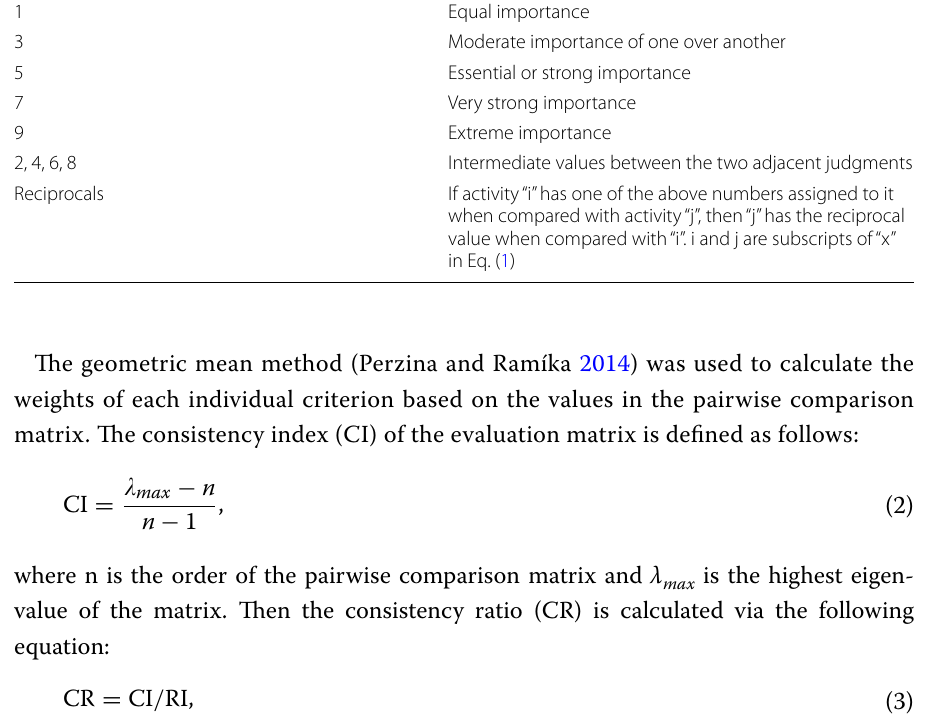
Table 1 The fundamental scale of the analytic hierarchy process (AHP) (Saaty, 1994) Intensity of importance on an absolute